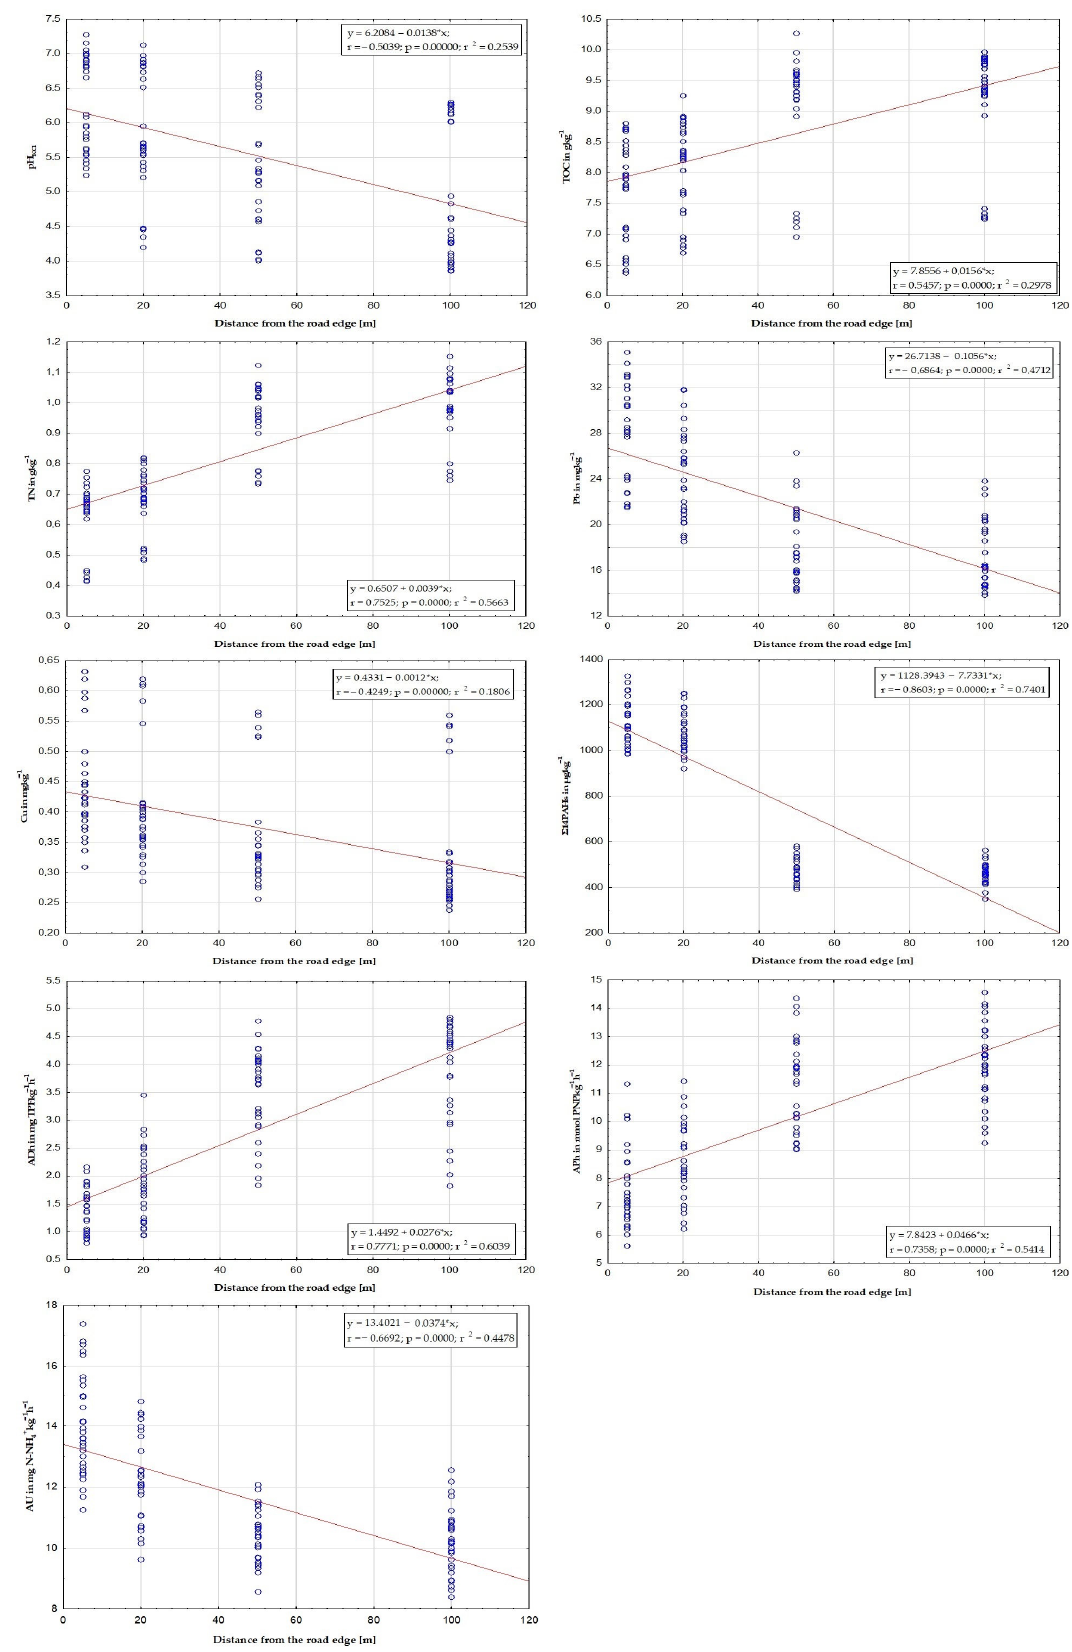
Figure 2. Regression analysis between studied soil parameters and distance from the road edge.